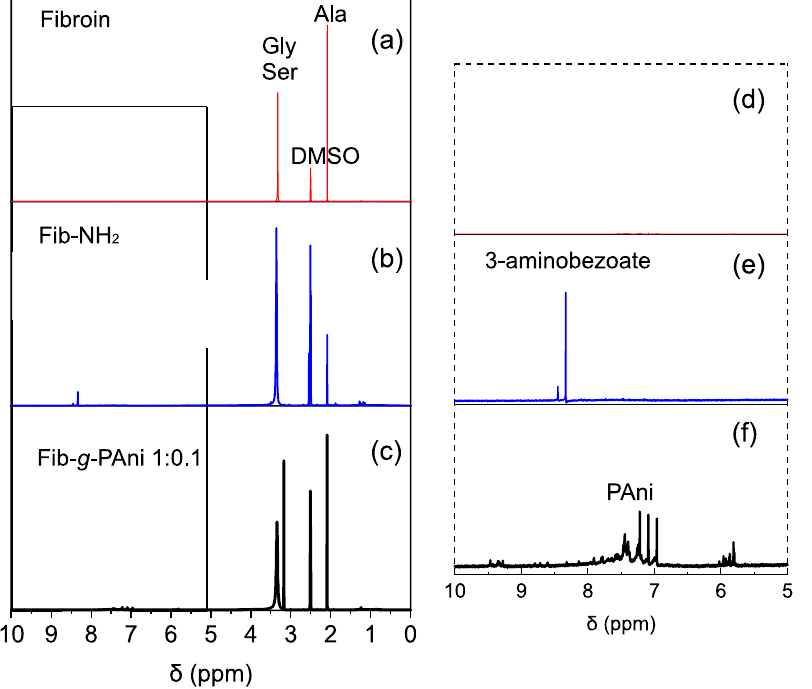
Figure 2. Proton NMR spectra ( a – c ) and zoom ( d – f ) from 5 to 10 ppm of these spectra. ( a , d ) Fibroin (Fib); ( b , e ) Fibroin esterified with aminobenzoate (Fib-NH 2 ); ( c , f ) Fibroin- g -polyaniline (Fib- g- PAni).